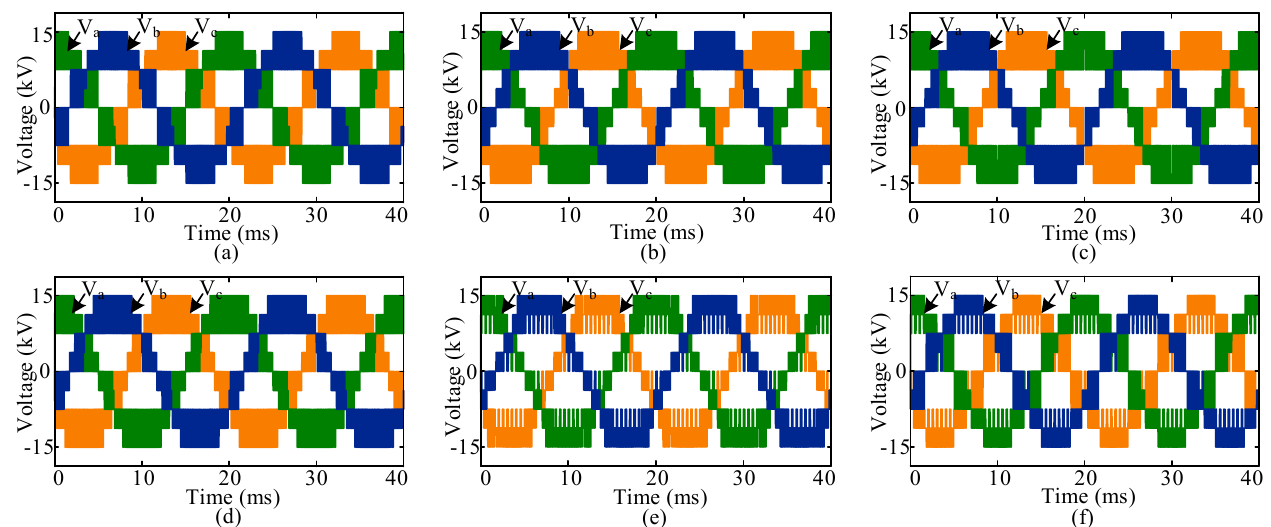
Figure 3. Inverter line voltage with modulation techniques: ( a ) SPWM, ( b ) THPWM, ( c ) CSVPWM, ( d ) THSDPWM, ( e ) TDBCPWM, and ( f ) SDBCPWM.